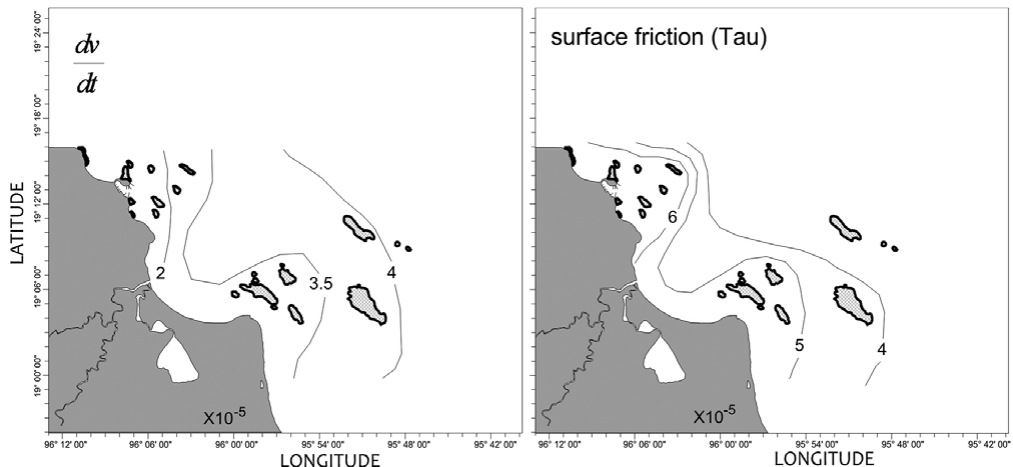
Fig. 9. – Annual mean principal modes of the current speed, calculated from the monthly yearlong data set from January to November